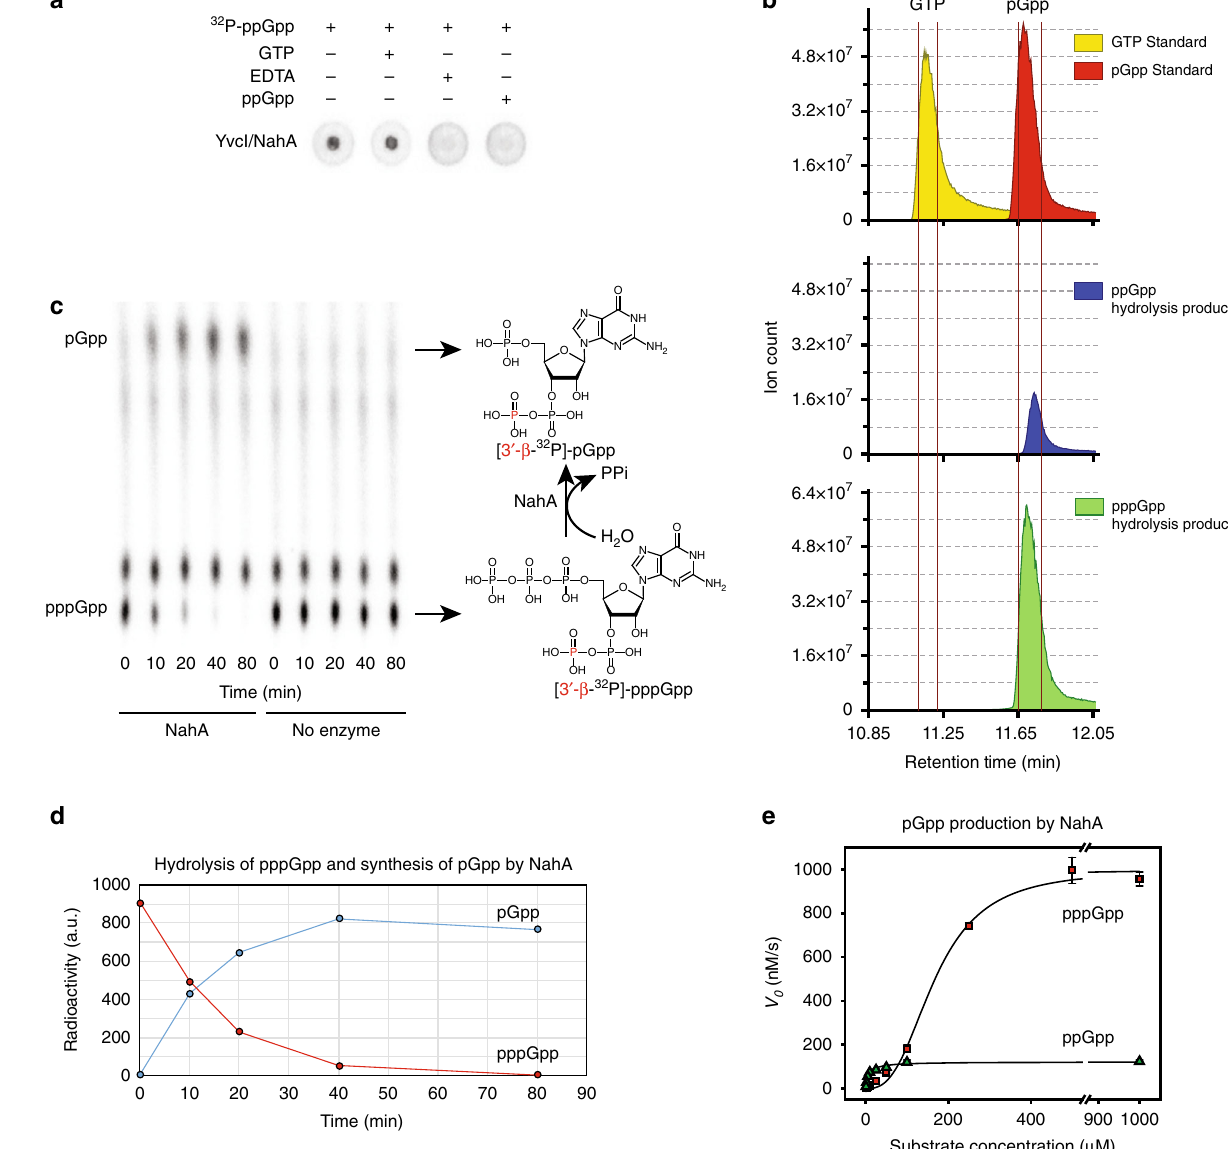
Fig. 2 NahA (YvcI) produces pGpp via (p)ppGpp hydrolysis. a DRaCALA of [5 ′ - α - 32 P]-ppGpp binding to B. subtilis HisMBP-tagged YvcI (NahA)